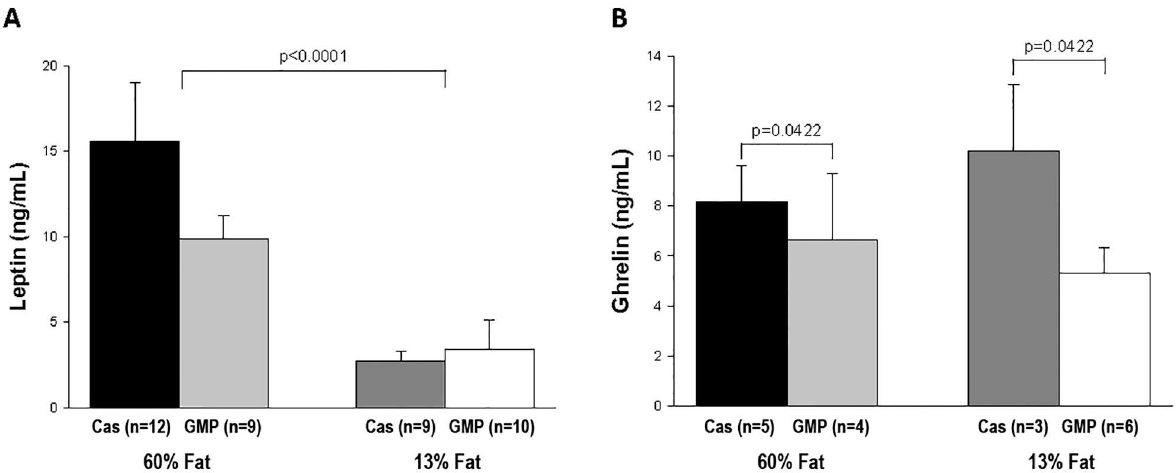
Fig 7. Plasma leptin and ghrelin concentrations. Plasma concentrations of leptin (A) and ghrelin (B) in female mice fed 60%-fat casein, 60%-fat GMP, 13%-fat casein, and 13%-fat GMP diets. Values are means ± SE; nos. in parenthesesindicate sample size. There was a significant fat effect in plasma leptin where mice fed the high-fat diets had a significantlygreater leptin concentration than mice fed the control diets (p < 0.0001). There was a significant protein effect in plasma ghrelin where mice fed the GMP diets had a significantly greater ghrelin concentration than mice fed the casein diets (p =